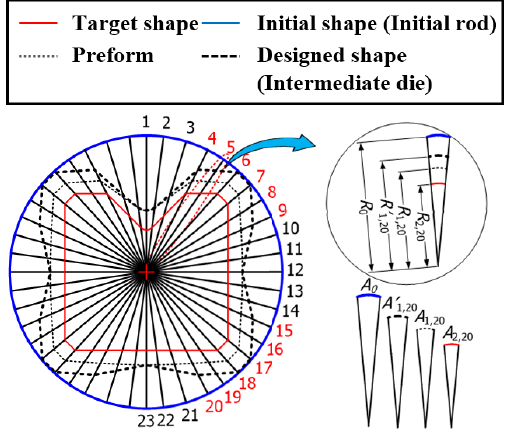
Figure 6. Intermediate die shape of the cross-roller guide.